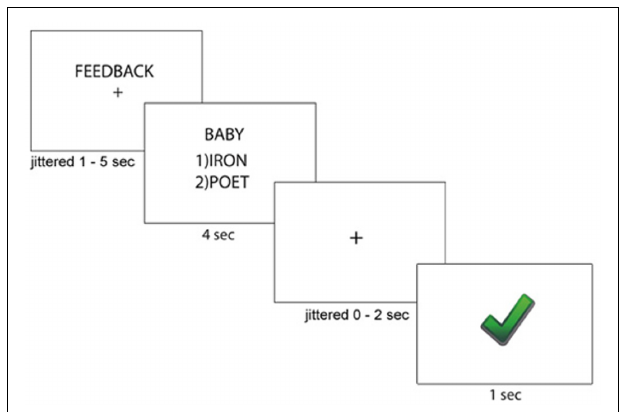
FIGURE 1 | Paired-Association Word Learning Task Description. Participants were told whether they would receive feedback for the current block. Then, participants viewed a target word with two word choices, and pressed the key responding to their word choice. Participants then saw immediate accurate feedback regarding their word choice.